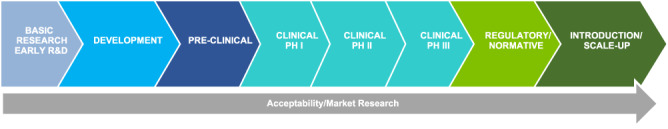
The stages of pharmaceutical product development.